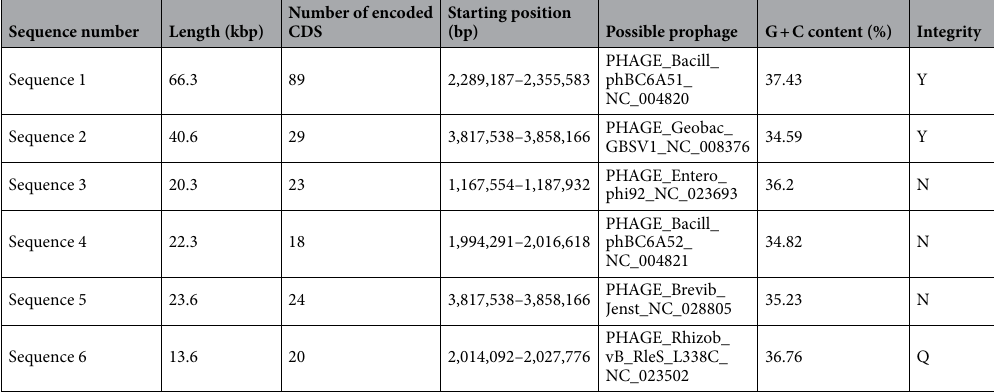
Sequence number